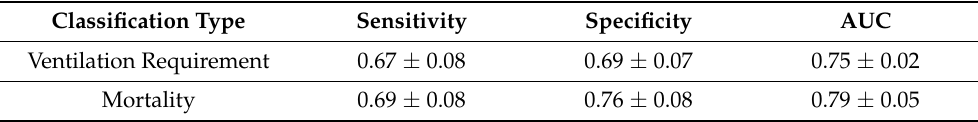
Table 4. Expert scores clinical outcome prediction results.